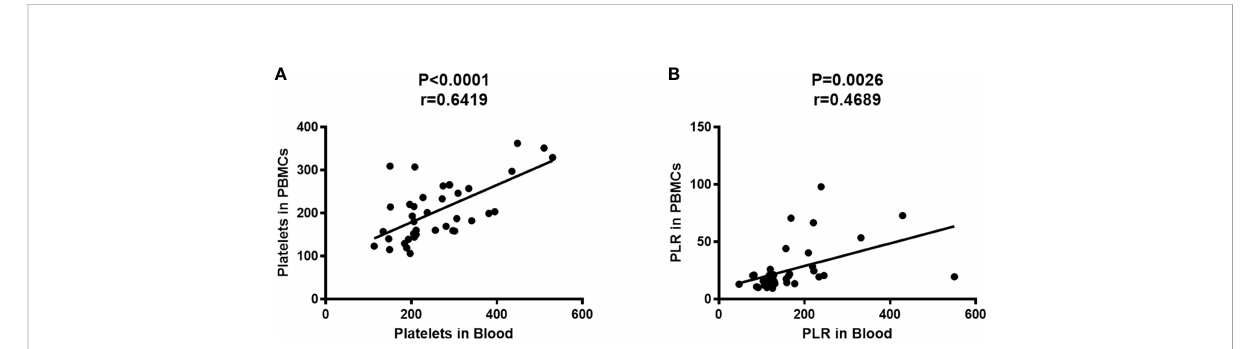
FIGURE 2 Platelet count in PBMCs was positively correlated with that in peripheral blood. The platelet counts and the lymphocyte counts in peripheral blood and PBMCs were measured by an automatic blood cell analyzer (n=39). Correlation analysis was performed using Spearman ’ s rho correlations. (A) The number of platelets in PBMCs was positively correlated with that in peripheral blood (P<0.0001, r=0.6419). (B) The PLR in PBMCs was positively correlated with that in peripheral blood (P=0.0026,